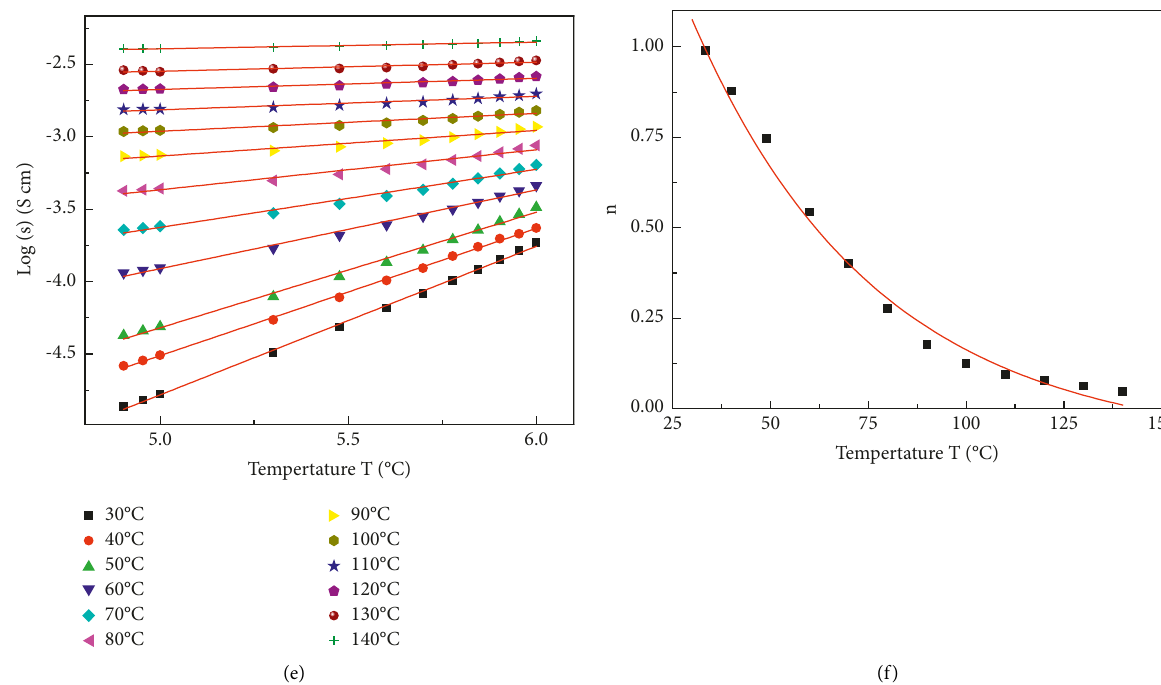
Figure 16: Log σ versus log f in the high-frequency region and the variation of the exponent n against the temperature: (a, b) 0.5wt.%, (c, d) 1.0 wt.%, and (e, f) 2.0wt.% FeCl 2 PVA/PVP blend electrolyte. Table 3: Values of the exponent n , coefficient A , and the DC conductivity for pure PVA/PVP blend sample. Low T ( ° C)